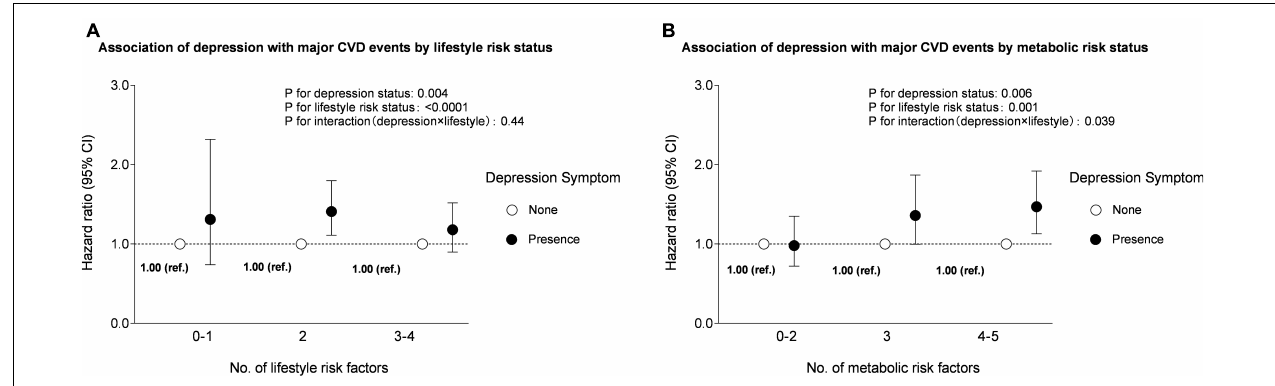
FIGURE 2 | Multivariable-adjusted HRs (95% CIs) for major CVD events according to the combination of depression with lifestyle and metabolic risk status. (A) Groups according to the combination of depression and lifestyle risk status. Adjusted for age, sex, education attainment (below high school, high school or above), marriage status (married, single, divorced, or widow), dwelling status (living alone, or not), family history of CVD (yes or no), BMI, central obesity (yes or no), high triglycerides (yes or no), low HDL-C (yes or no), high blood pressure (yes or no), and high glycemia (yes or no). (B) Groups according to the combination of depression and metabolic risk status. Adjusted for age, sex, education attainment (below high school, high school, or above), marriage status (married, single, divorced, or widow), dwelling status (living alone, or not), family history of CVD (yes or no), BMI, unhealthy diet (yes or no), physical inactivity (yes or no), alcohol intake (non-ideal or ideal), and ever smoking (yes or